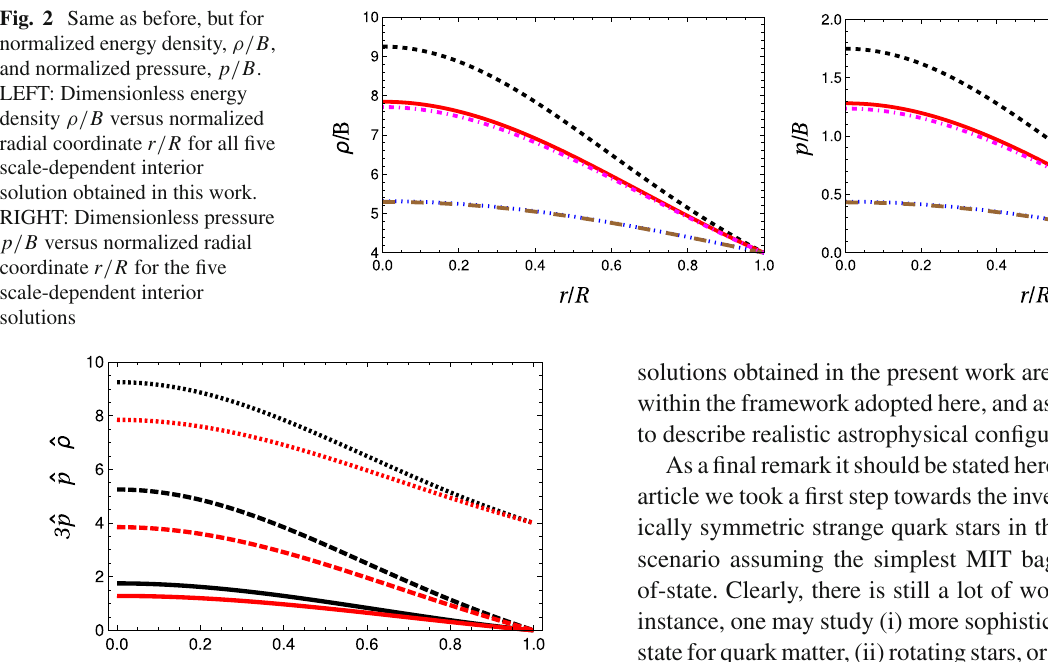
coupling G ( r ) versusnormalizedradialcoordinate r / R forallfivescale- dependent interior solutions obtained here. MIDDLE: Metric potential e 2 ν versus normalized radial coordinate r / R . RIGHT: Mass function (in solar masses) m ( r )/ M sun versus normalized radial coordinate r / R